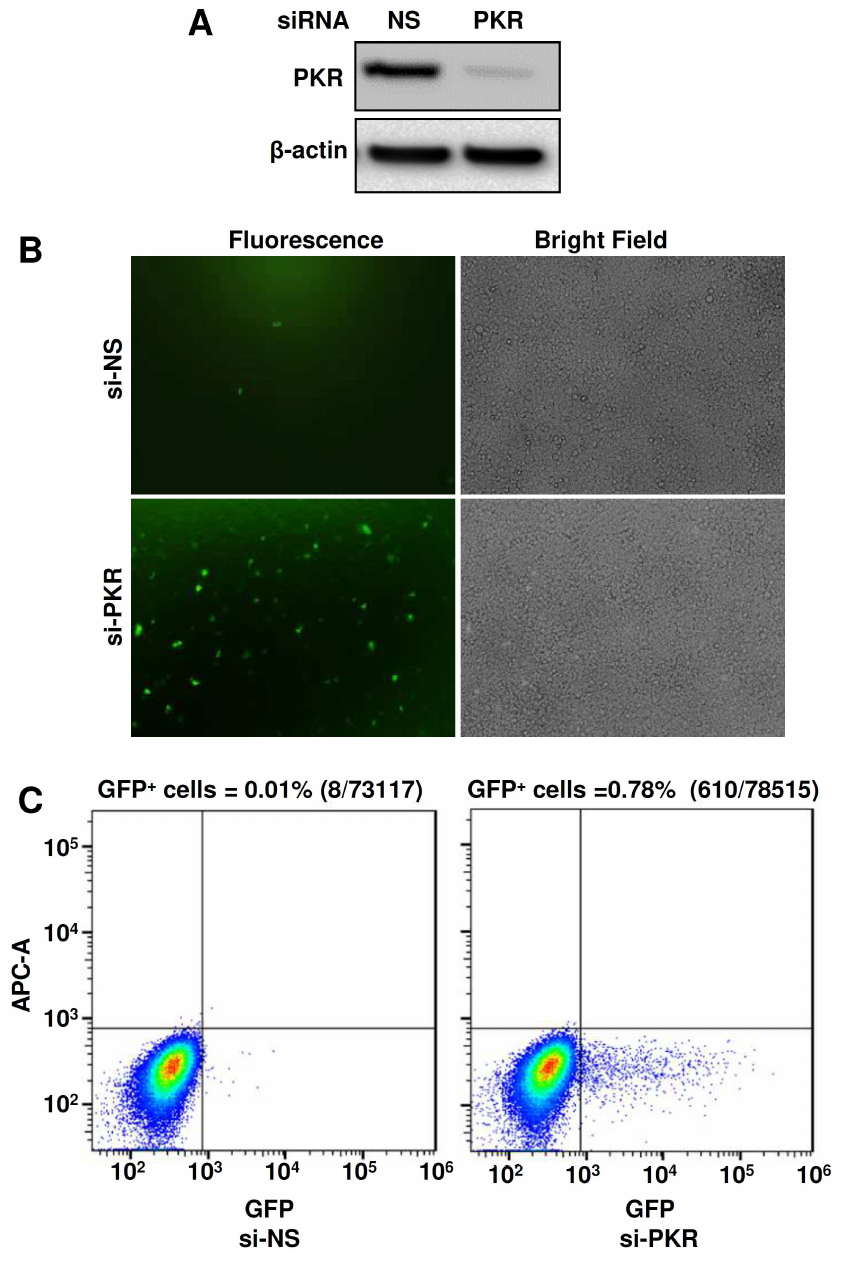
Fig 10. Knockdown of PKR expressionincreasesproduction of KSHV virions. (A) Knockdownof PKR expressionby a PKR-specific siRNA in iSLK-BAC16 cells by Western blot analysis. (B) Analysis of KSHV virus productionafter siRNA knockdown of PKR expression. KSHV replicationin iSLK-BAC16 cells was inducedby treatment with 1 mM sodium butyrate and 1 μ g/ml doxycycline for 5 days. Supernatants obtained from the inducediSLK-BAC16 cells, which containGFP-viruses, were used to infect HEK293cells. The infected HEK293cells were observed at 48 h infection for GFP expressionas an indicationof KSHV infection. (C) Virus-infected GFP-positive HEK293 cells were quantitated by FACS analysis. Each transfection/ inductionwas performed in triplicate and three replicateinfectionswere performed with each supernatant. Number of GFP-positive cells over the total numberof cells in each infectionwas counted and expressedas a percentage (%). One representativeof three infectionsis shown.